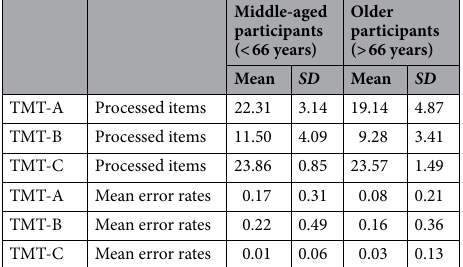
Table 1. Number of processed items and errors during TMT-A, TMT-B and TMT-C, depending on